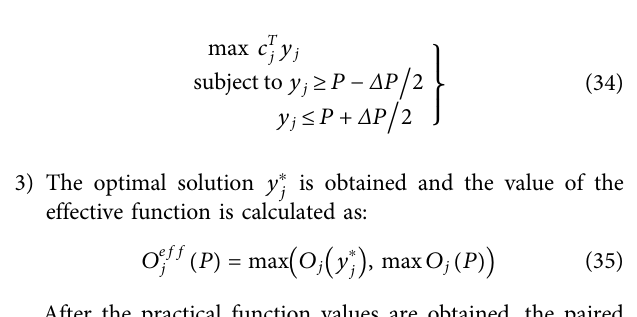
FIGURE 5 | Daily loads of cooling, heating, power, and domestic hot